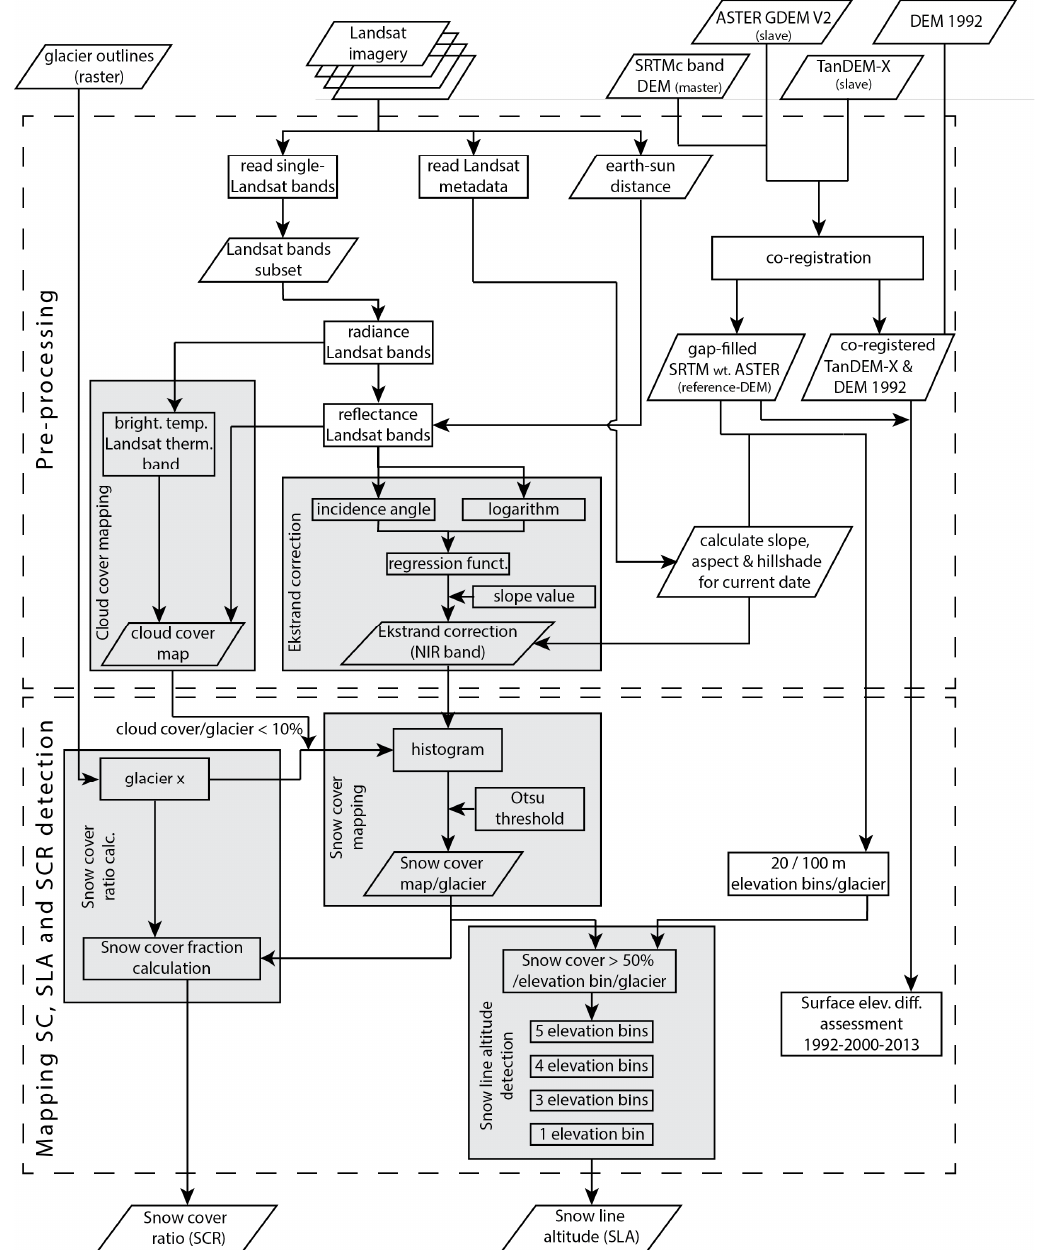
Figure 2. Generalized data processing flow chart of ASMAG.